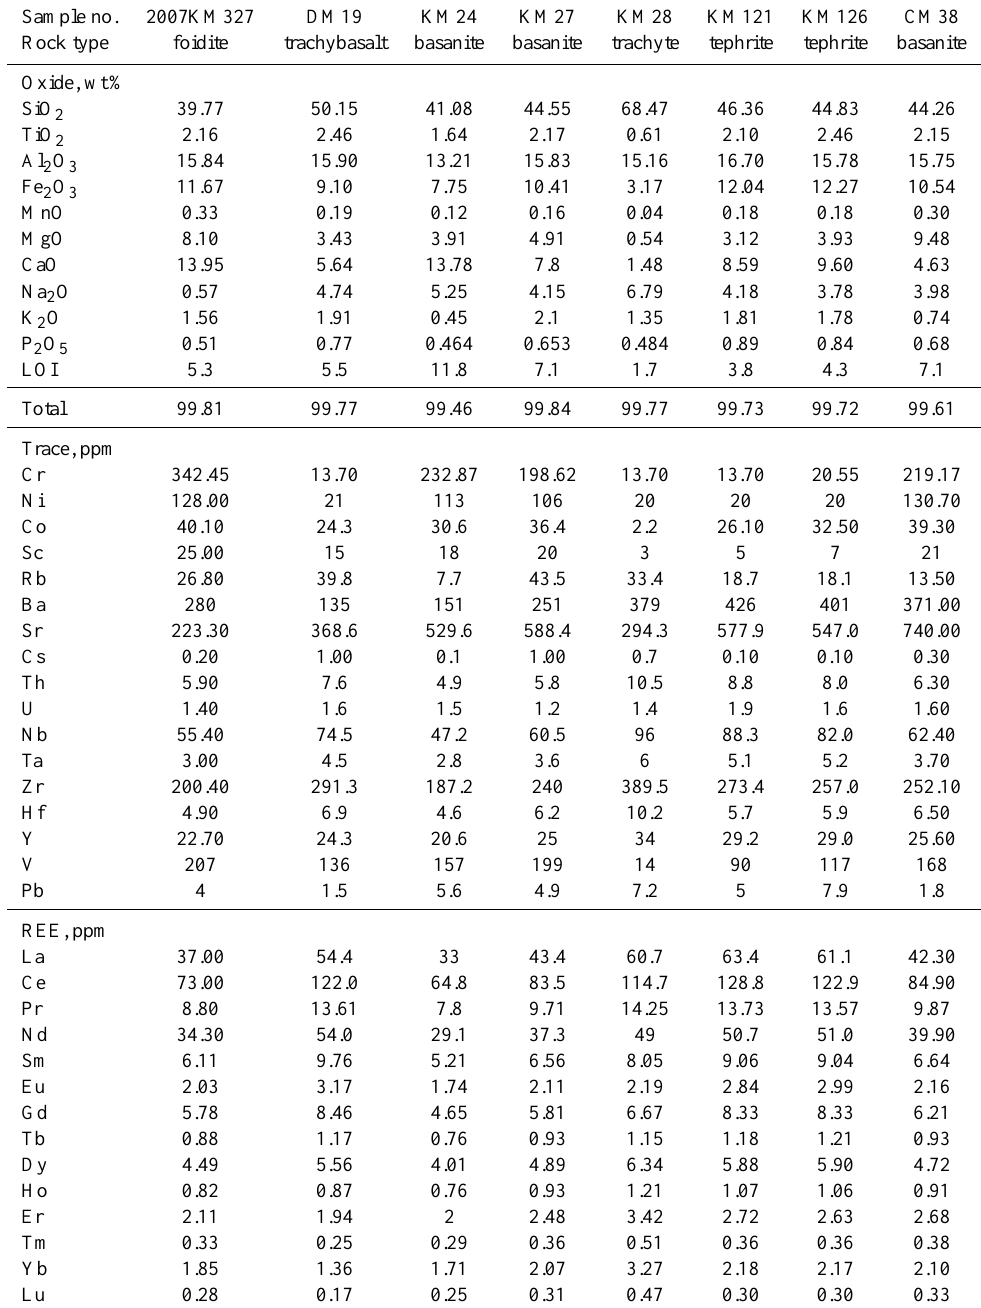
Table 6. Major, trace element and REE data for a select group of seamount volcanic rocks from the Ankara Mélange. Sample